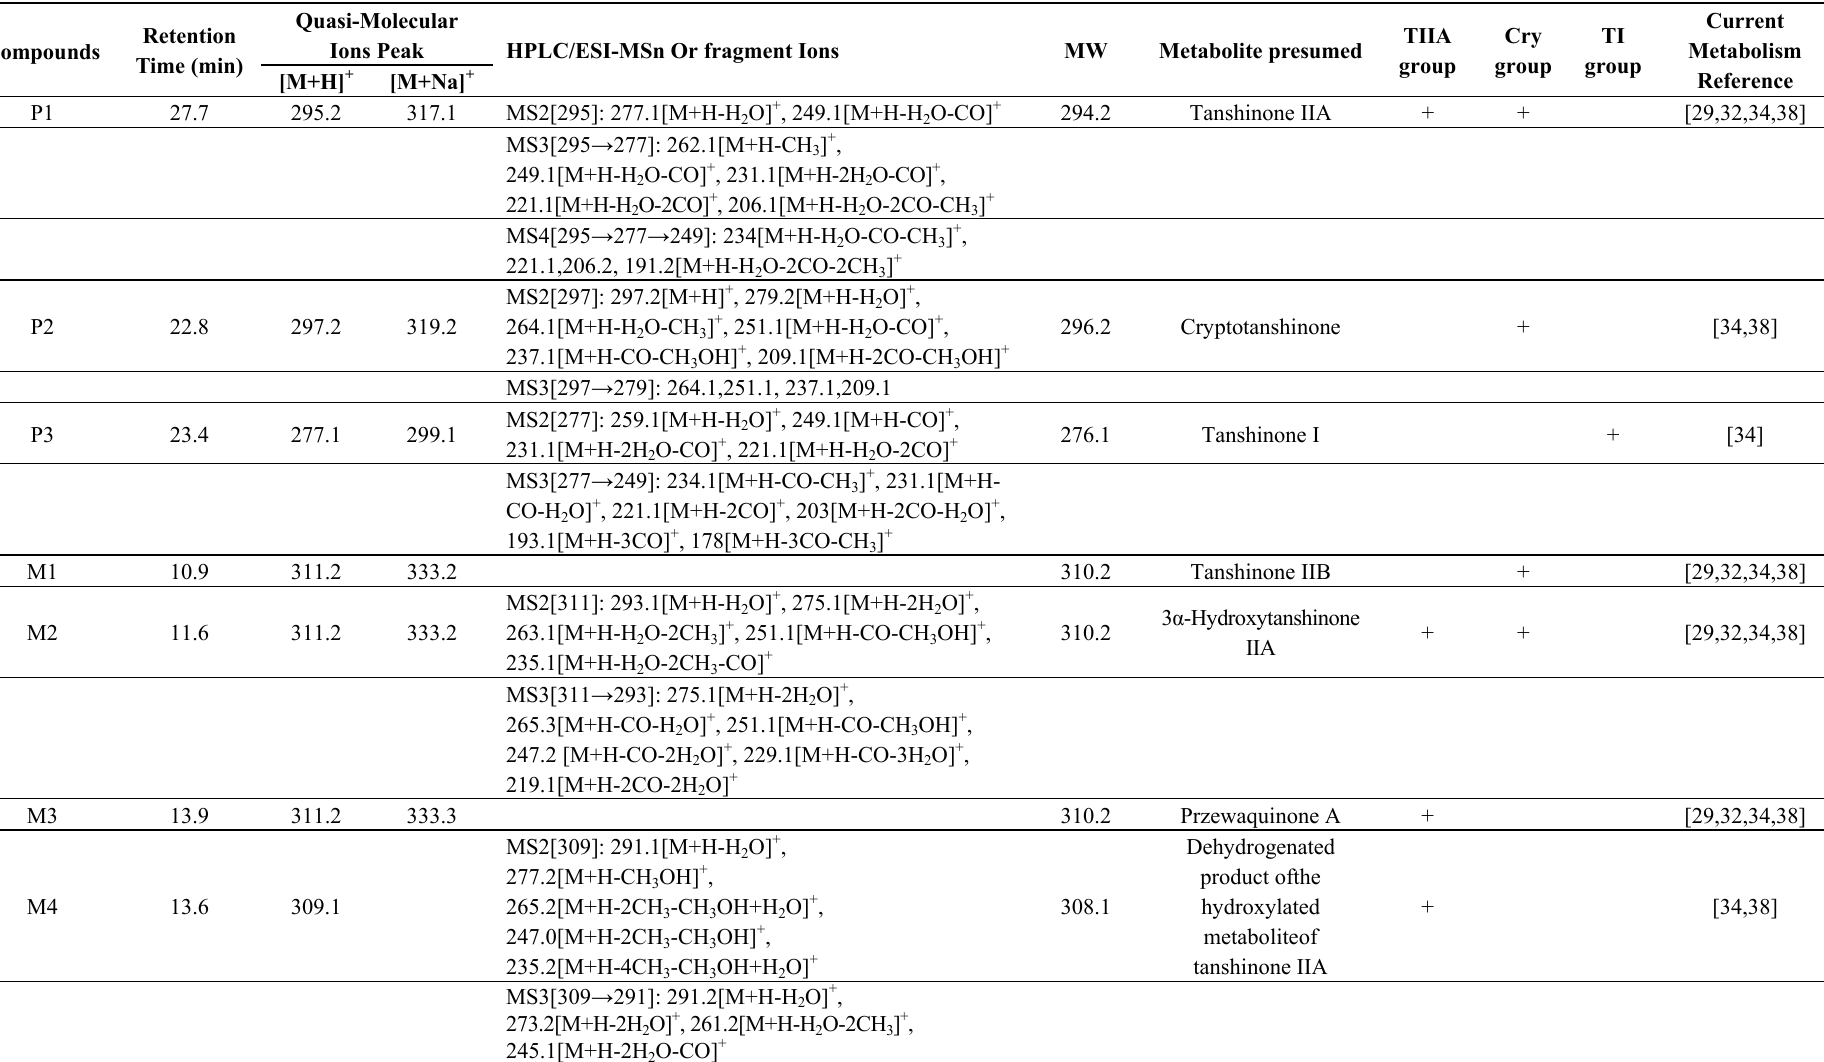
Table 1. MS data for TIIA, Cry, TI and their metabolites after zebrafish exposure for 24 h.